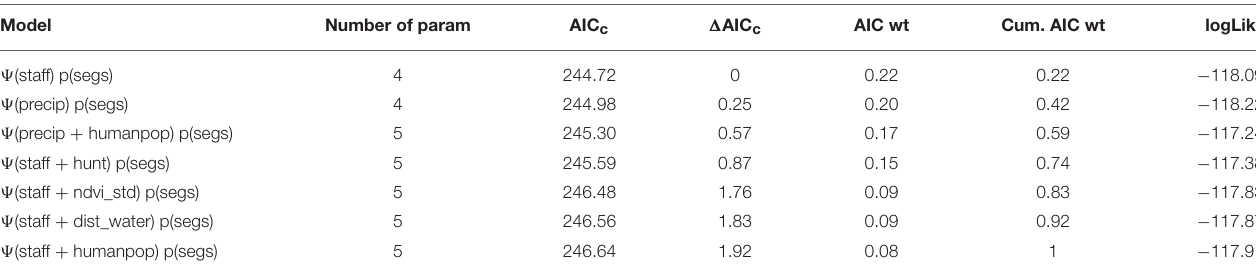
TABLE 3 | Results of multivariate model selection for estimating lion occupancy ( 9 ) in WAP.